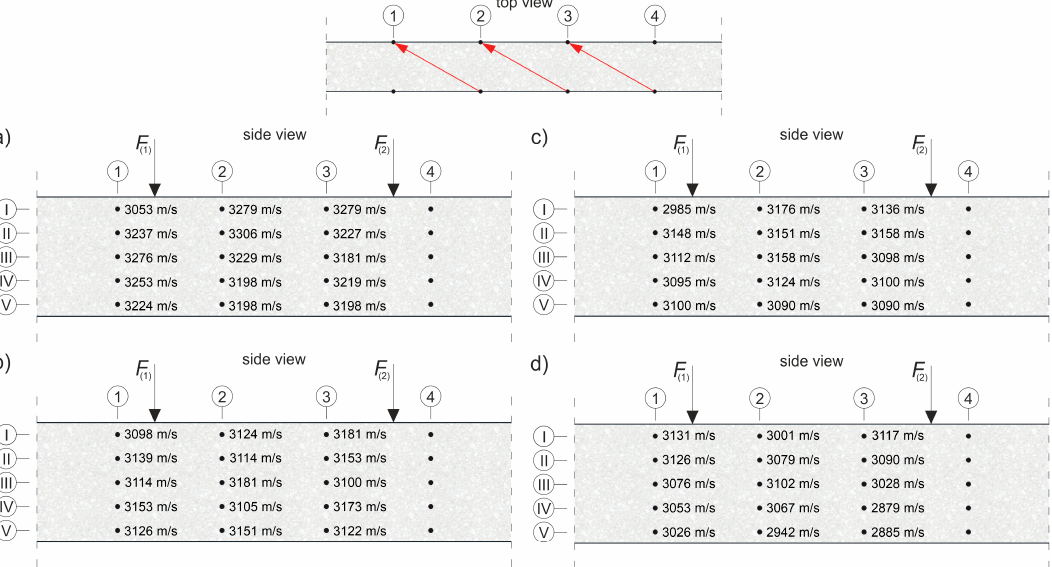
Figure 33. Velocities of the longitudinal waves in beam #3 propagating between the sending and receiving points situated diagonally with one point offset in the left direction, before: ( a ) stage 1, ( b ) stage 2, ( c ) stage 3, ( d ) stage 4.